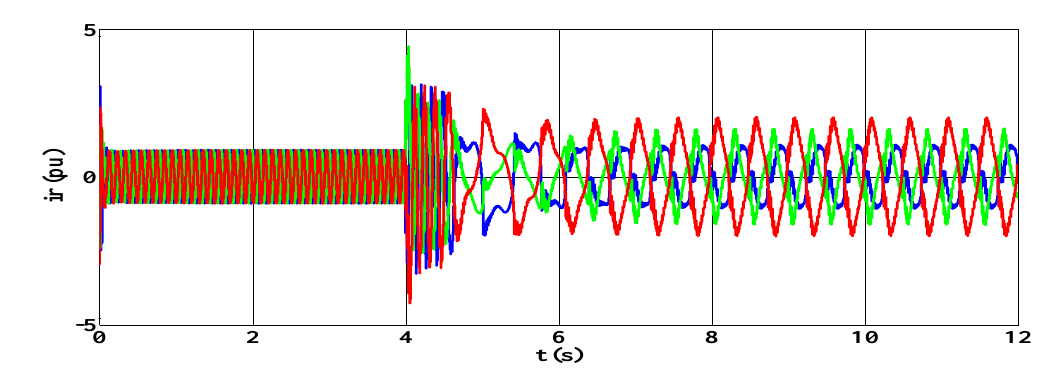
Figure 26. Rotor currents (short-circuit happens at t = 4 s).